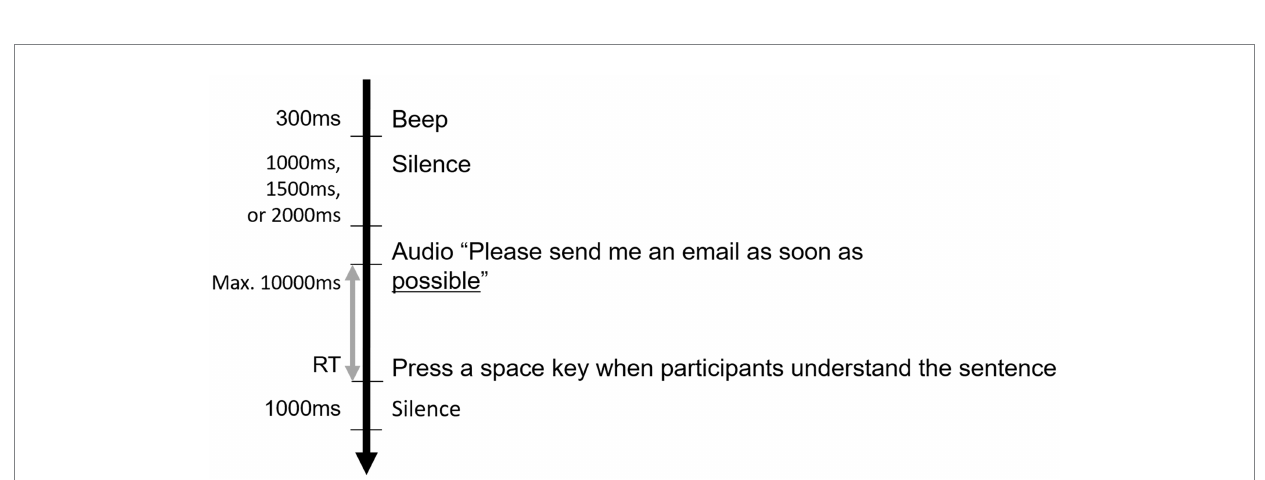
FIGURE 3 The flow of comprehension tasks in the main task. The black arrow indicates the flow of one trial. The times on the left side indicate the duration of the activities. Each trial began with a beep sound and finished with silence that lasted for 1,000 ms. RT (represented by the gray arrow) indicates the response time for sentence comprehension. Each sentence was played once. The underlined word is the last word of the target